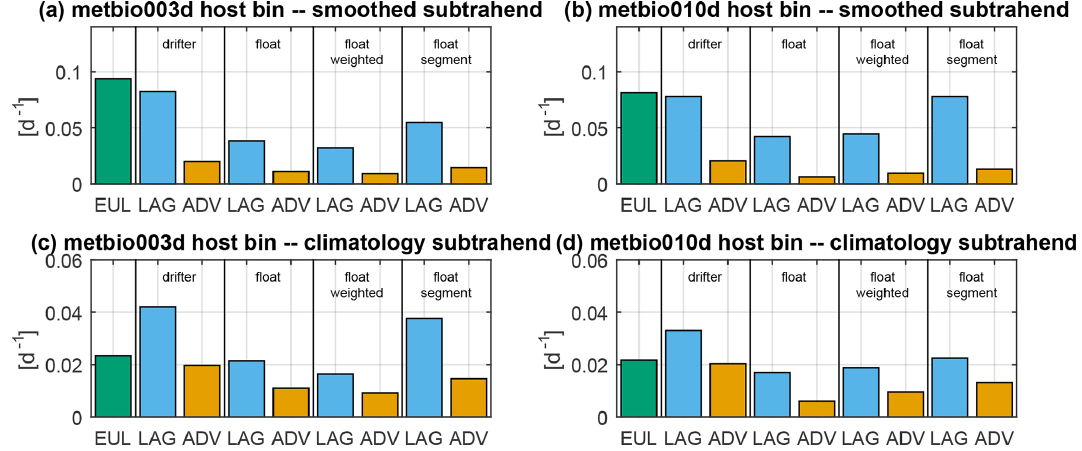
Figure 7. Magnitude of the material derivative terms for log-transformed surface chlorophyll using Eq. (5) in the two space bins hosting the rapidly profiling metbio ∗ segments. The Eulerian tendency (EUL, bluish green) term is plotted on the left of each panel, and the Lagrangian tendency (LAG, blue) and eddy advection (ADV, orange) terms are displayed separately for drifters, floats, floats with average scales weighted by QPI − 2 , and the metbio ∗ segments themselves. Panels (a) and (b) are calculated from Chl anomalies relative to the smoothed subtrahend, and panels (c) and (d) are calculated from Chl anomalies relative to the climatological subtrahend. Panels (a) and (c) are for the bin hosting the metbio003d segment, and panels (b) and (d) are for the bin hosting the metbio010d